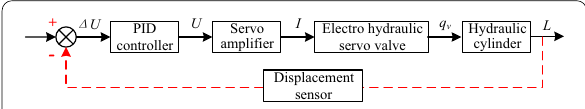
Figure 5 Control block diagram of hydraulic